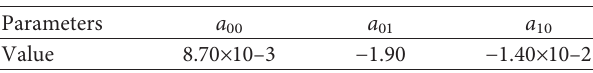
Table 4: The parameters of c .